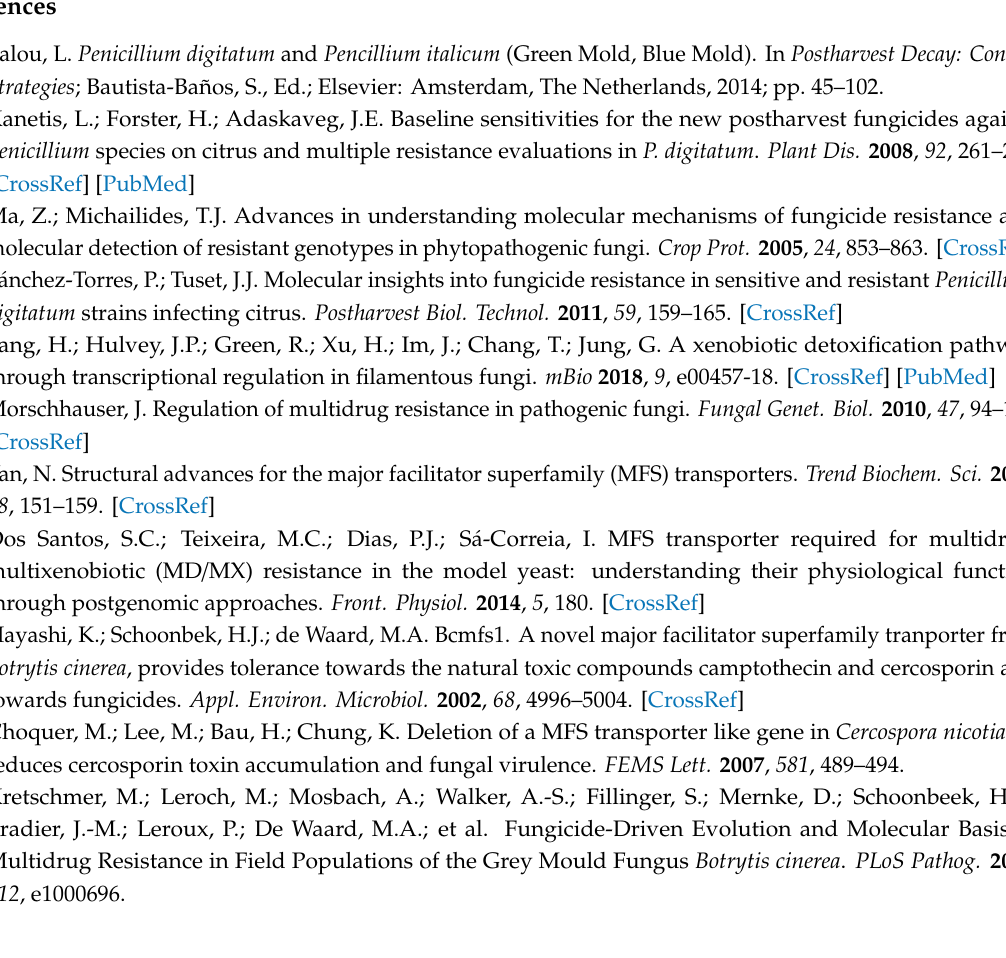
Table S1: Oligo sequence used in this study, Figure S1: Evaluation of virulence of Pd27 overexpression